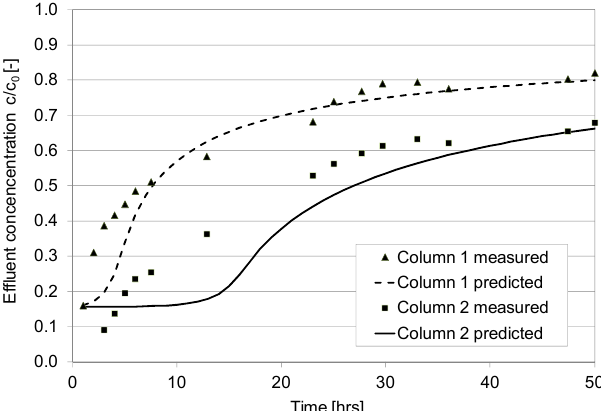
Figure 7. Experimental and predicted breakthrough curves of pre-treated HTC fine mulch PW.